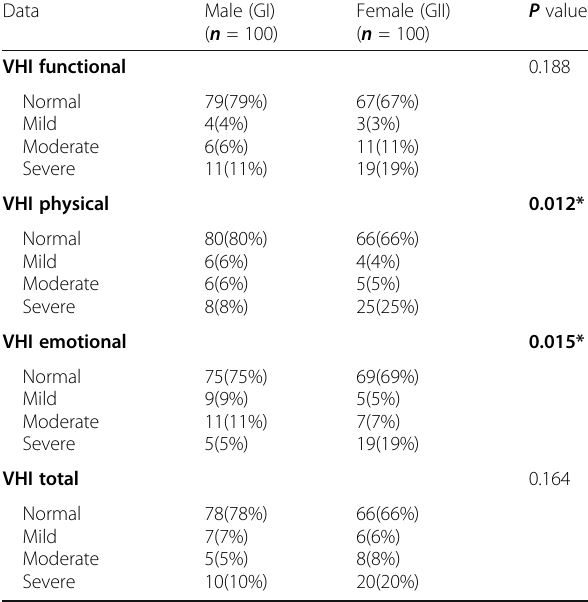
Table 8 Comparison between male and female teachers in VHI